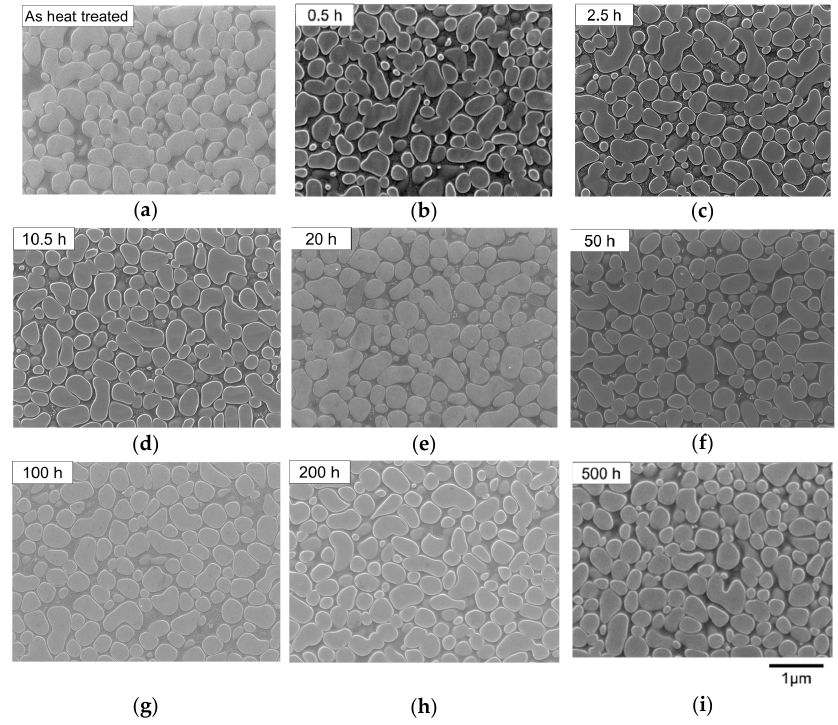
Figure 2. Microstructure after long-term aging at 760 °C without load. ( a ) As heat treated, ( b ) 0.5, ( c ) 2.5, ( d ) 10.5, ( e ) 20, ( f ) 50, ( g ) 100, ( h ) 200, ( i ) 500 h aged at 760 °C.